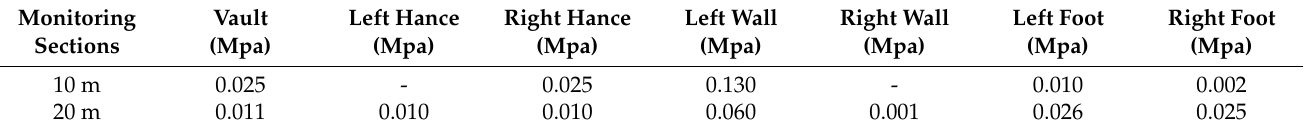
Table 4. Surrounding rock pressure.